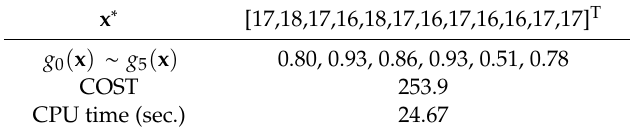
Table 3. The superb solution x ∗ , cost, service-levels and the CPU times in the small